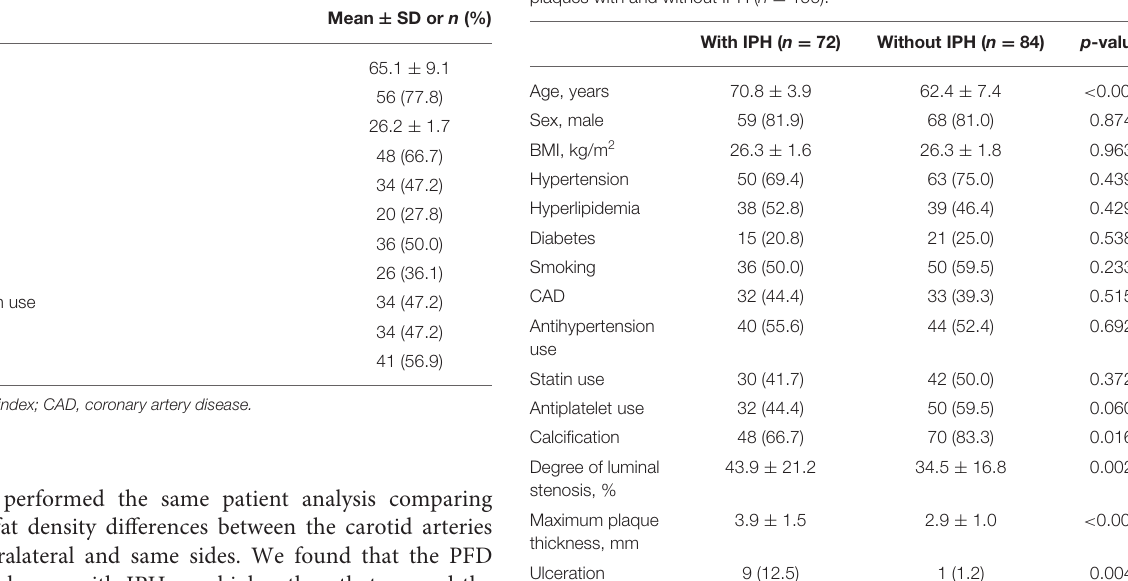
TABLE 1 | Clinical characteristics of the study population ( n = 72). TABLE 2 | Comparison of clinical risk factors and CTA characteristics between plaques with and without IPH ( n =